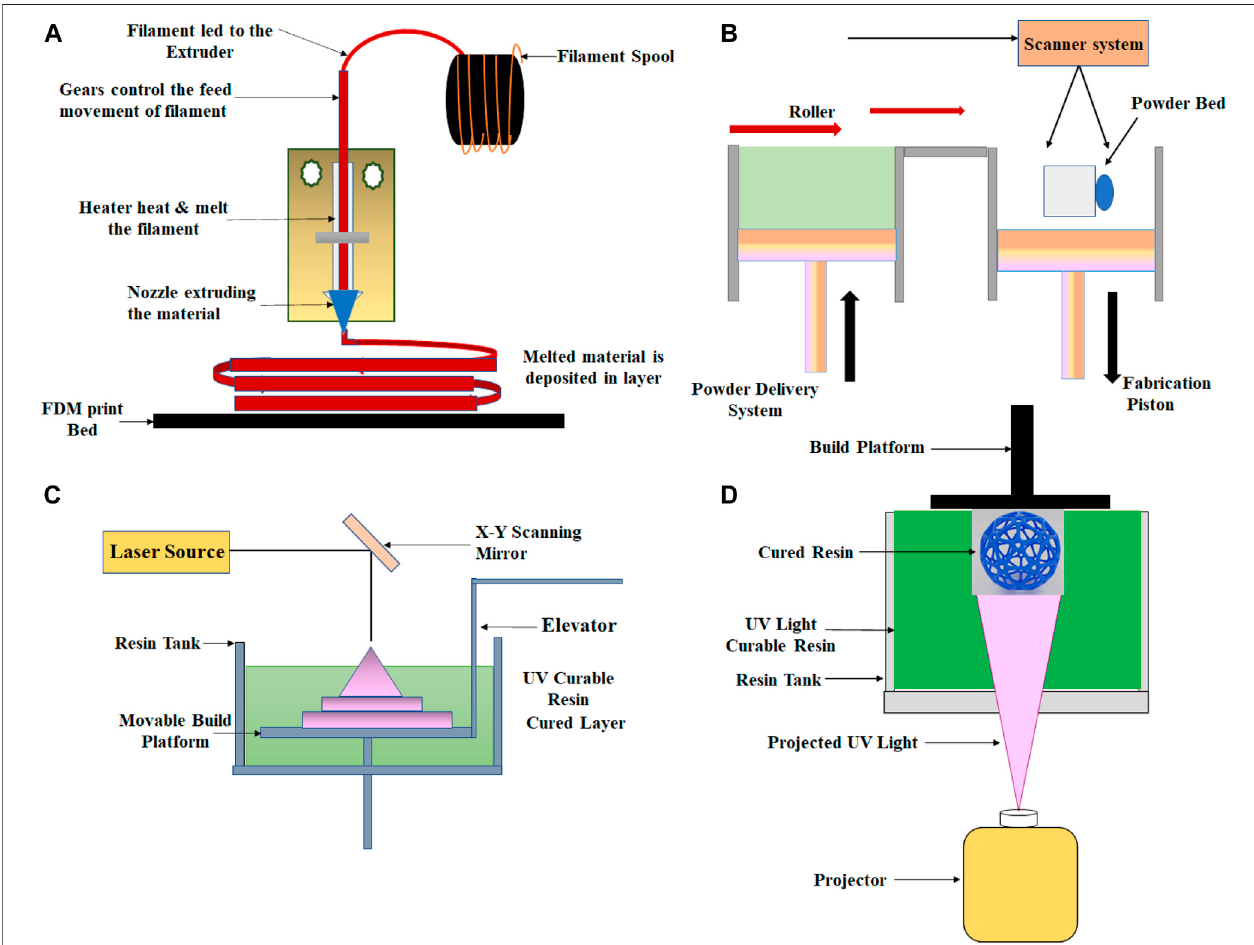
FIGURE 2 | Schematic showing the setup for (A) fused deposition modeling, (B) selective laser sintering, (C) stereolithography, and (D) Digital light processing technique.